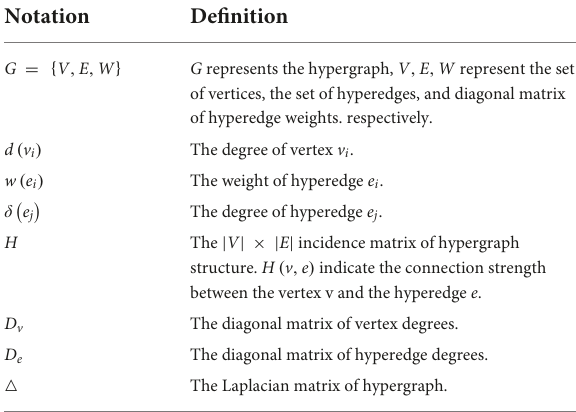
TABLE 1 Symbols and definitions of